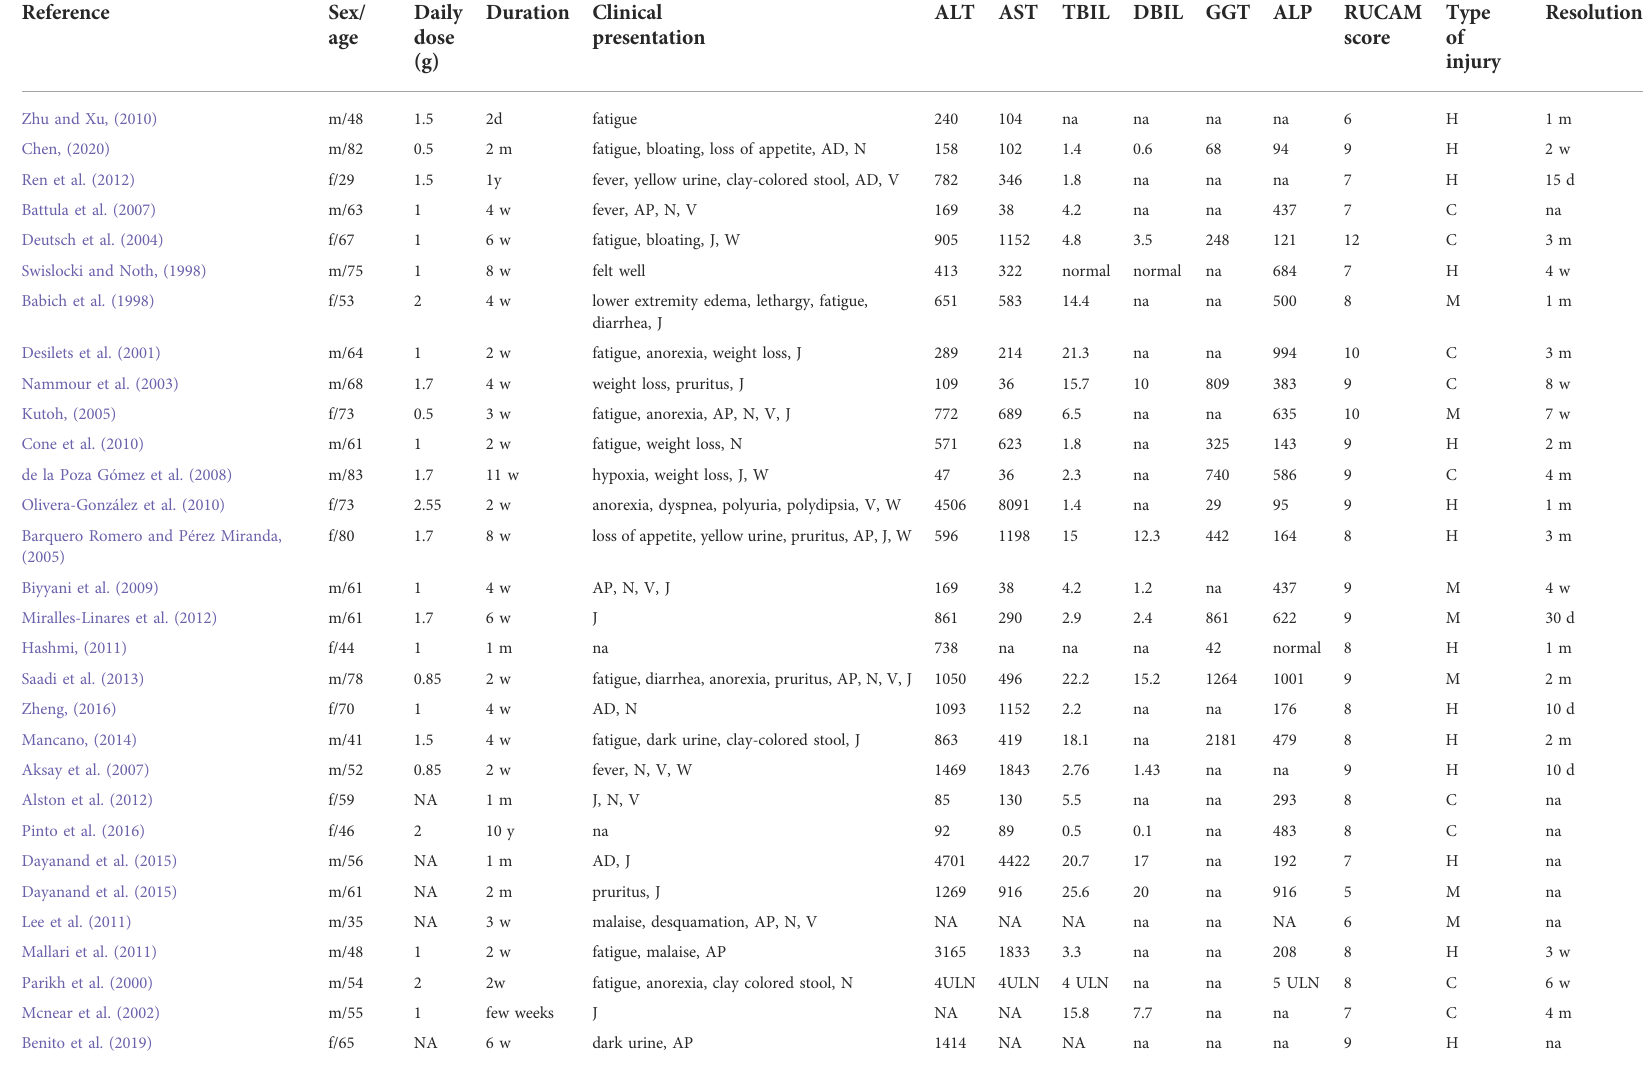
TABLE 1 Clinical data of 30 patients with metformin-induced